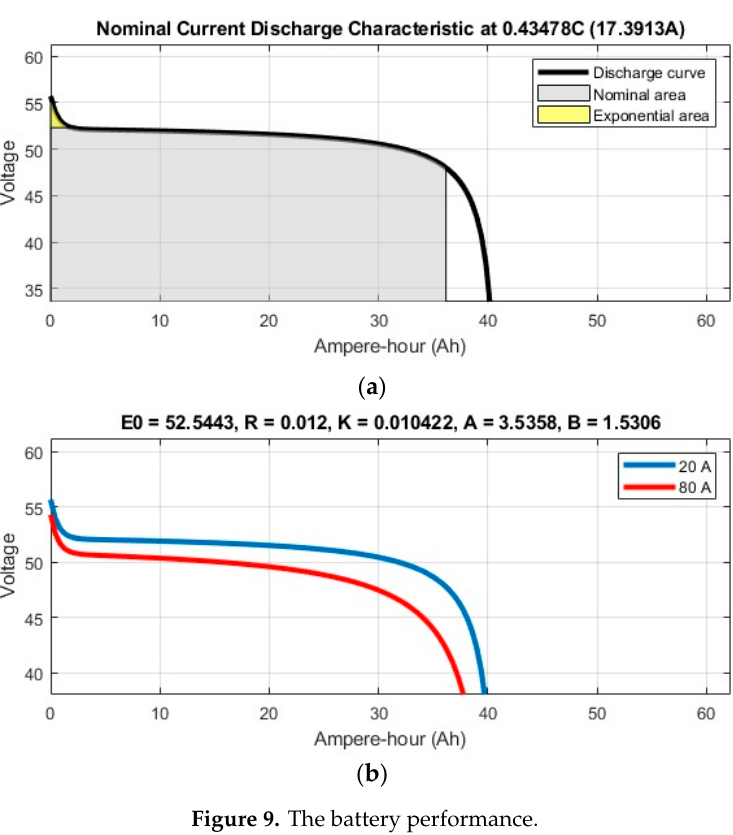
Figure 9. The battery performance.